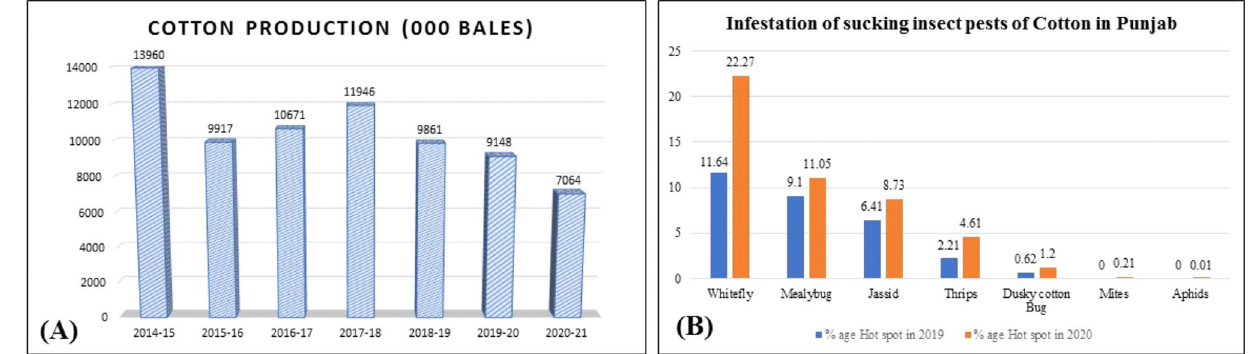
Figure 1. (A) Cotton production of Pakistan (B) Whitefly infestation in cotton belt of Punjab,